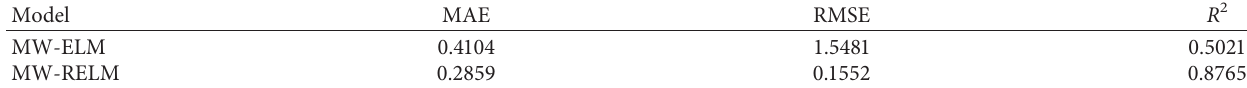
Table 10: Quantitative indicators under different soft-sensor models.